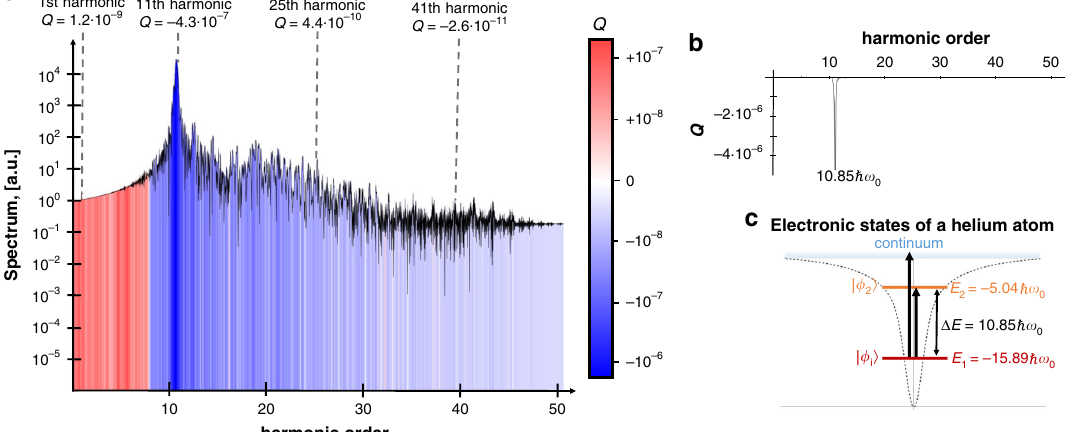
Fig. 3 Photon statistics of HHG in the single-atom regime. a HHG spectrum with the background color showing the Mandel parameter Q ; red corresponds to super-Poissonian statistics ( Q > 0), white corresponds to Poissonian statistics ( Q = 0), and blue corresponds to sub-Poissonian statistics ( Q < 0). b Dependence of the Mandel parameter Q on the frequency of the emitted radiation. c Illustration of the electronic states of the helium atom. The energy difference between ground and excited level equals to the frequency of resonance in the Mandel parameter. All the parameters of the numerical calculations are the same as in Fig. 2. Our numerical calculations assume a single atom, although the same conclusions apply up to several thousands of atoms with a larger Q (Supplementary Note